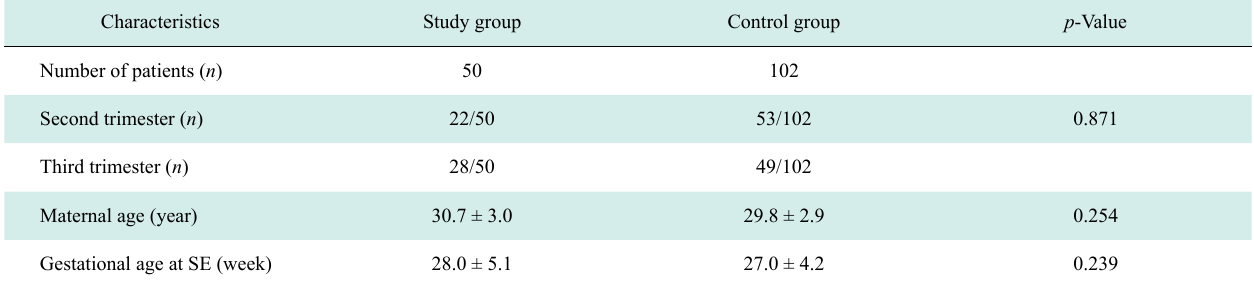
Table 1 General characteristics of 152 pregnant women Characteristics